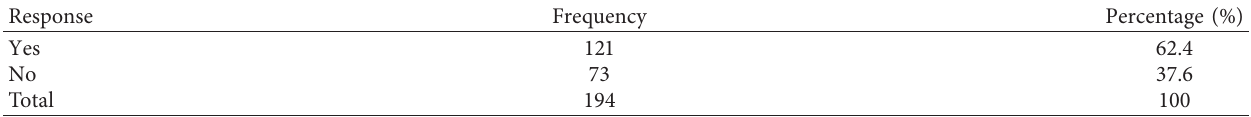
Table 3: Influence of leaflet information on respondents’ decision to stop taking the medication. Response